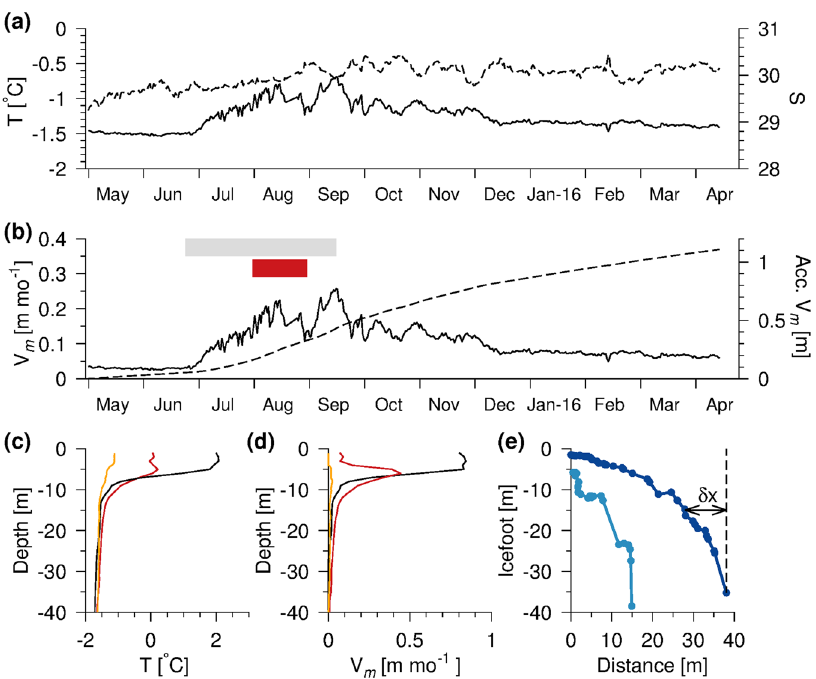
Figure 5. Melt rates and icefoot. ( a ) Temperature (solid line) and salinity (dashed, triangle) from mooring at station M. ( b ) Melt rate and accumulated melt during the periods where duration of ice breakup (gray bar) and open water in front of the terminus (red bar) are indicated. ( c ) Temperature (transect III, black), station NS (red) and a profile from April 2015 (orange), ( d ) the corresponding melt rates and ( e ) observed ice foot (transect I, light blue; transect III, blue) and glacier melt ( δ